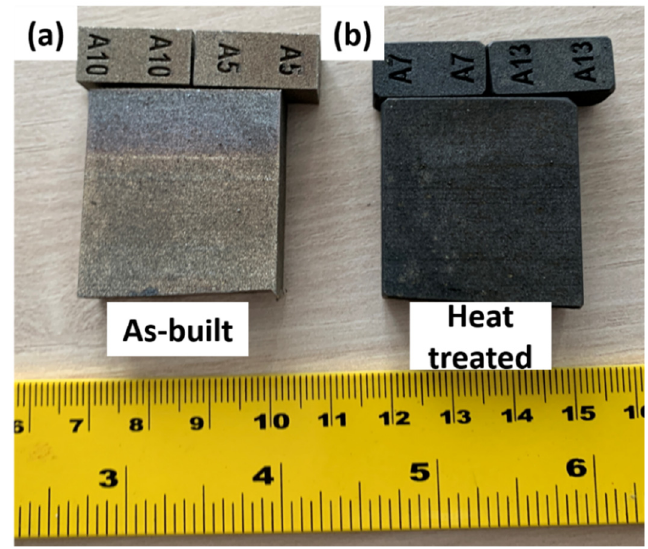
Figure 3. Image showing the ( a ) as-built and ( b ) heat-treated samples.